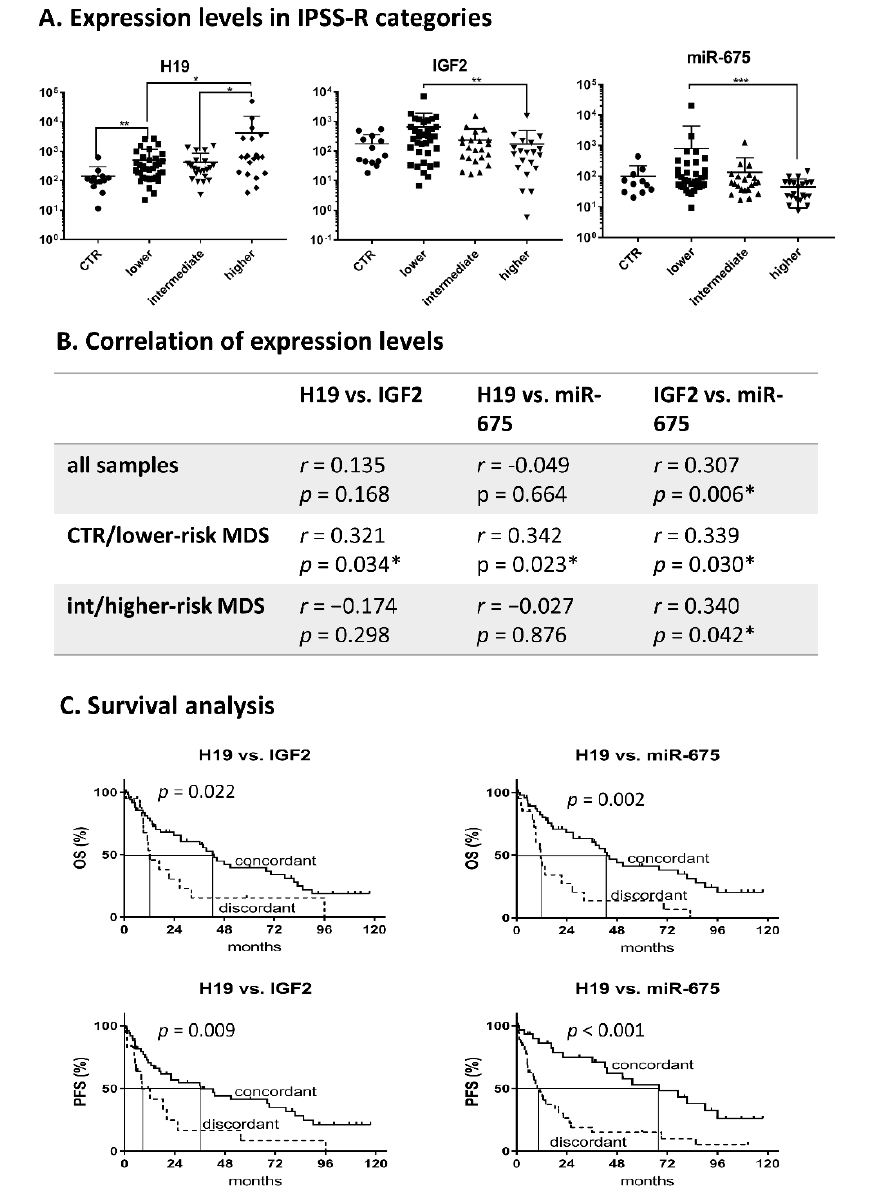
Figure 5. Expression of H19, IGF2, and miR-675. ( A ) Relative expression levels in MDS patients (testing cohort) grouped according to IPSS-R. ( B ) Correlation of expression levels (Spearman test) in different sample groups. ( C ) Kaplan-Meier curves for overall survival (OS) and progression-free survival (PFS) in MDS patients with concordant vs. discordant expression of the H19/IGF2 and H19/miR-675 pairs. * p < 0.05, ** p < 0.01, *** p < 0.001.